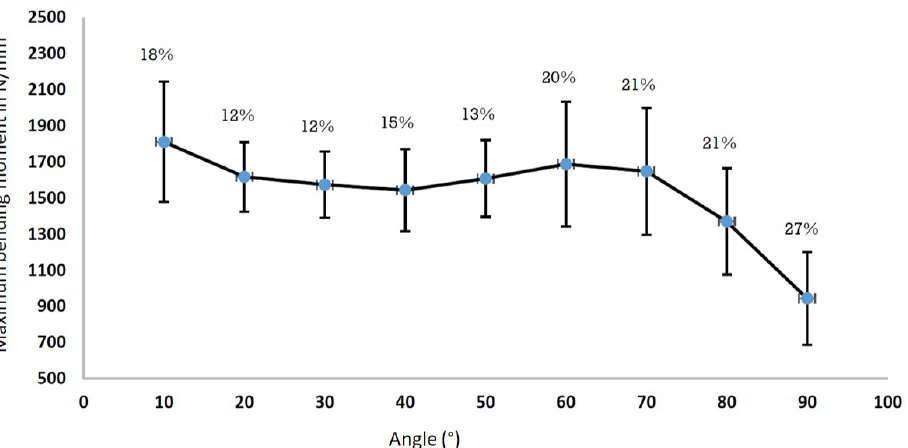
Figure 7. Repeatability of results on a subject. Mean value and range of variation for each measure- ment